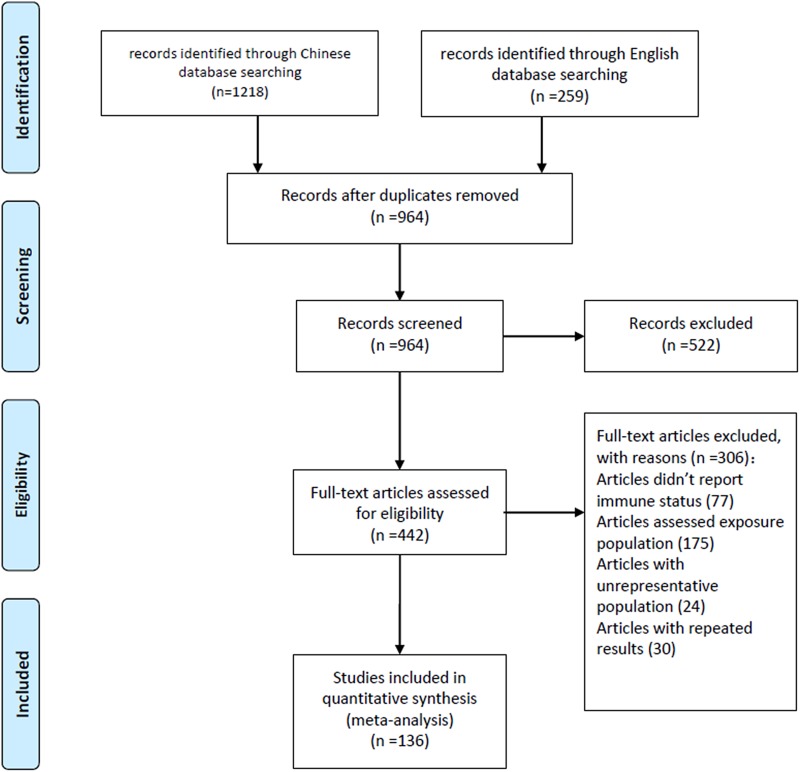
Flowchart of included articles in the meta-analysis.